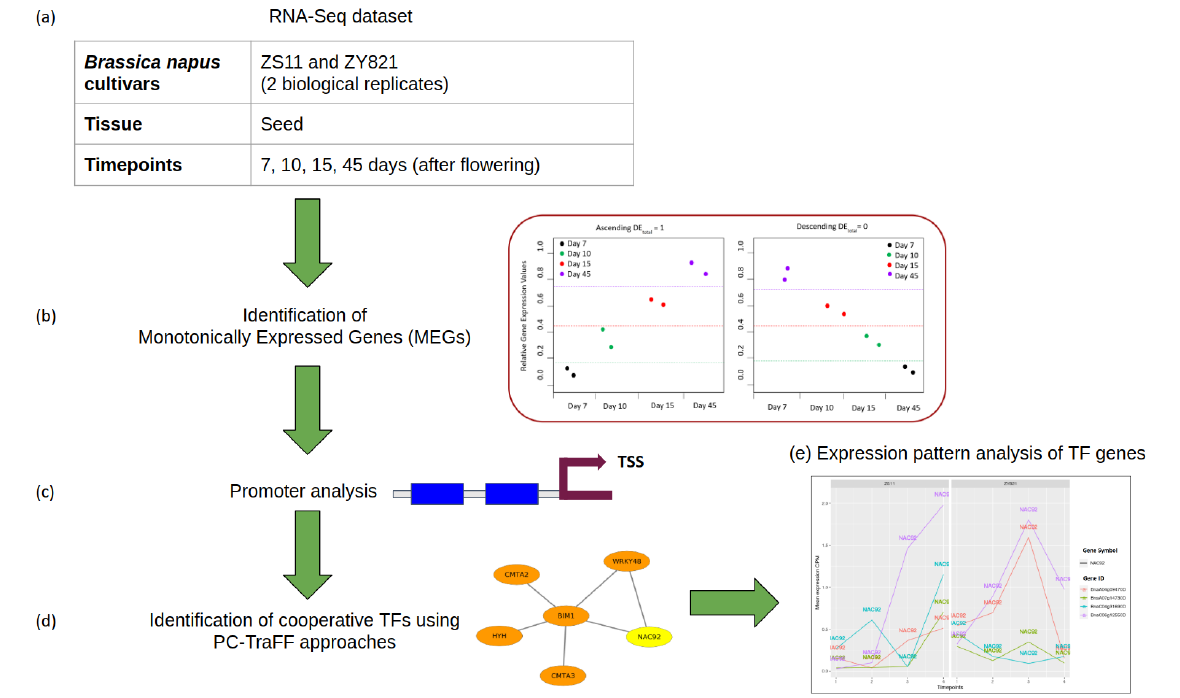
Figure 11. Flowchart of analysis. ( a ) Processing of the RNA-Seq dataset; ( b ) identification of Monotonically Expressed Genes using the MFSelector approach [93]; ( c ) promoter analysis (TSS: transcription start site); ( d ) identification of cooperative transcription factors (TFs) using the PC-TraFF approach [42]; and, ( e ) Expression pattern analysis of TF